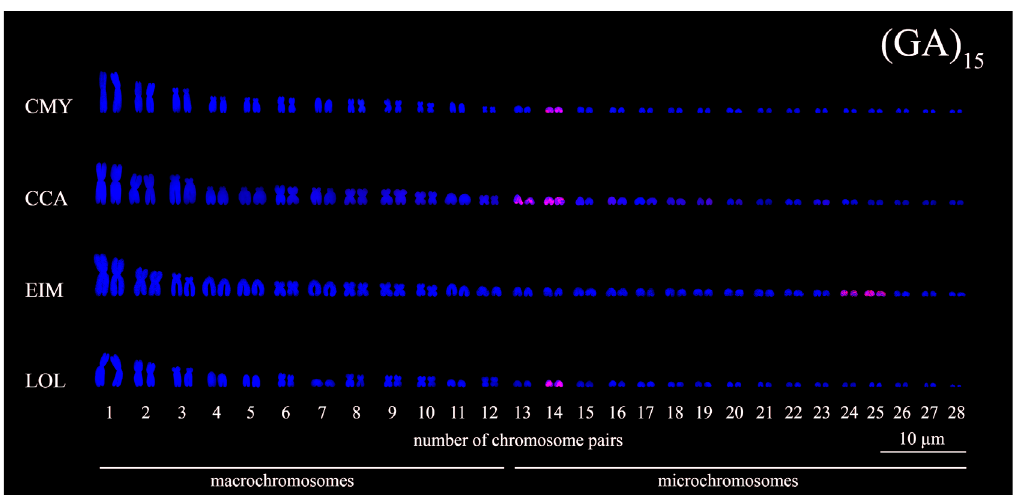
microsatellites probes ( red signals ). The species names were referred by 10